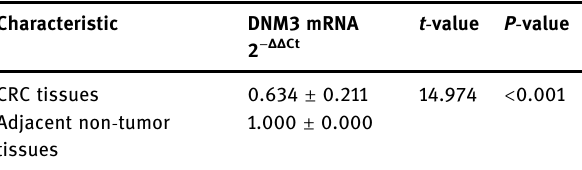
Table 1: DNM3 expression in CRC and adjacent non - tumor colorectal